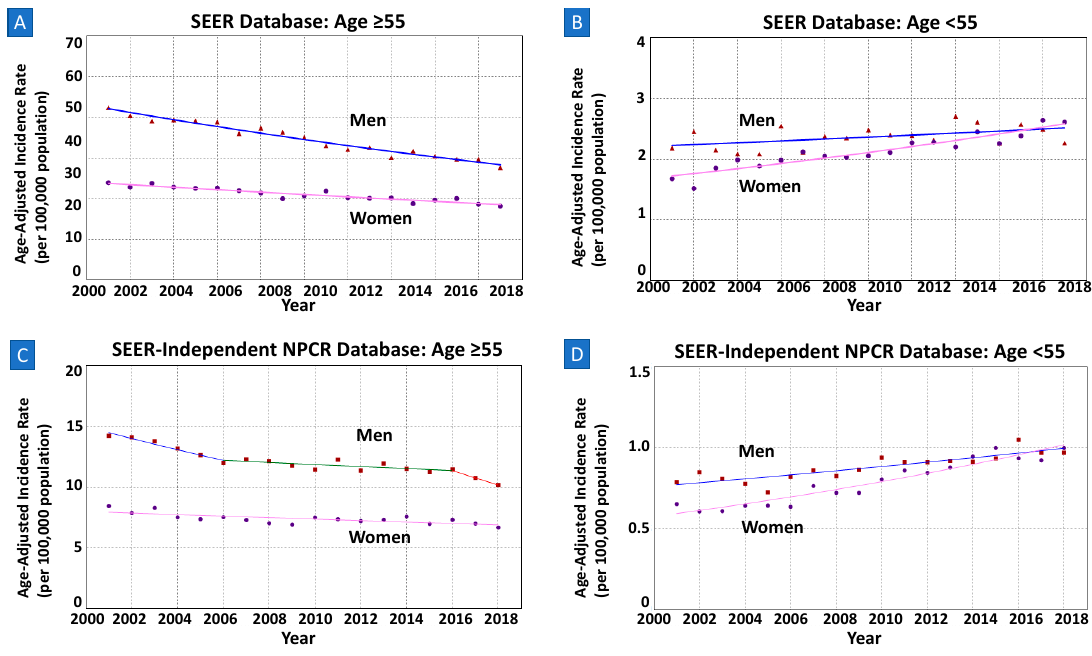
Figure 1. ( A ) In SEER, among those aged ≥ 55 years, APC in men is decreasing at a greater rate than in women with non-parallel trends (AAPC − 2.44% vs. − 1.64%; p -value < 0.01). ( B ) In SEER, among those aged <55 years, incidence increased in women but remained stable in men (AAPC 2.01% vs. 0.29%; p -value < 0.01). ( C , D ) In SEER-Independent NPCR, both findings in those of age ≥ 55 and <55 were similar to the analyses of SEER database.